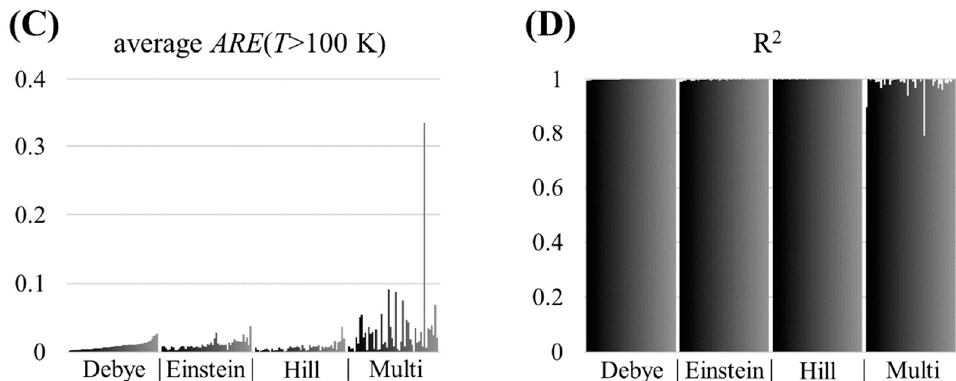
Figure 5. Evaluation metrics of specific the heat models. Each vertical bar is from data analysis on a single covalent solid from the 53 compounds that were fit to specific heat expressions. The results of Debye Model fits to all 53 solids are shown leftmost in each graph, whereas the Multilinear Model (Multi) fits to all 53 solids are shown rightmost in each graph, with Einstein and Hill Equation fits nested left and nested right within each graph. ( A ) Average absolute relative error (AARE) of each model fit to each solid for data from temperatures below 100 Kelvin, unitless. Low AARE reflects a better model fit. ( B ) Standard error in J/(mole ⋅ Kelvin) of each model fit to each solid across all available temperature data. Low standard error reflects a better model fit. ( C ) Average absolute relative error (AARE) of each model fit to each solid for data from temperatures above 100 Kelvin, unitless. Low AARE reflects a better model fit. ( D ) Correlation coefficient of each model fit to each solid. Unity correlation reflects a better model fit.